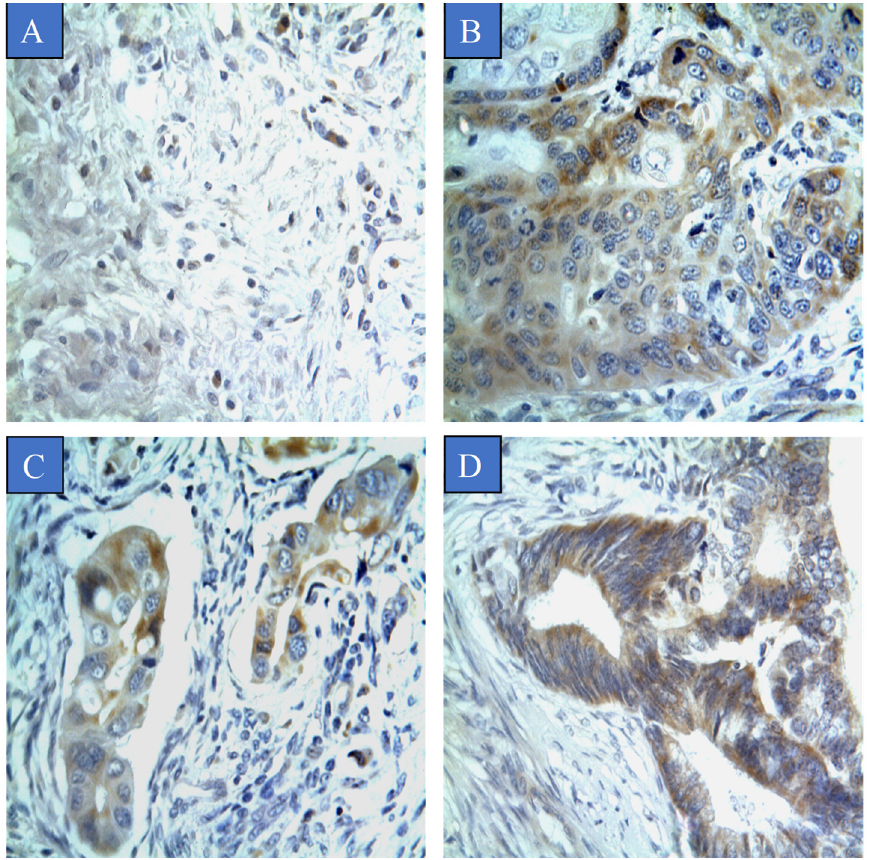
Figure 2. CYP4Z1 expression in different types of cervical cancer. Tumours were classified on the basis of pathological subtype: ( A ) normal cervix tissue; ( B ) squamous cell carcinoma; ( C ) adenocarcinoma, and; ( D ) endometrioid adenocarcinoma. Magnification